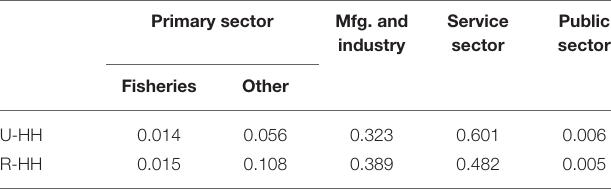
TABLE 1 | Share of household consumption spending on commodity.